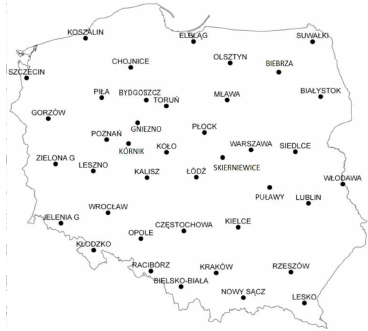
Figure 1. Location of the meteorological